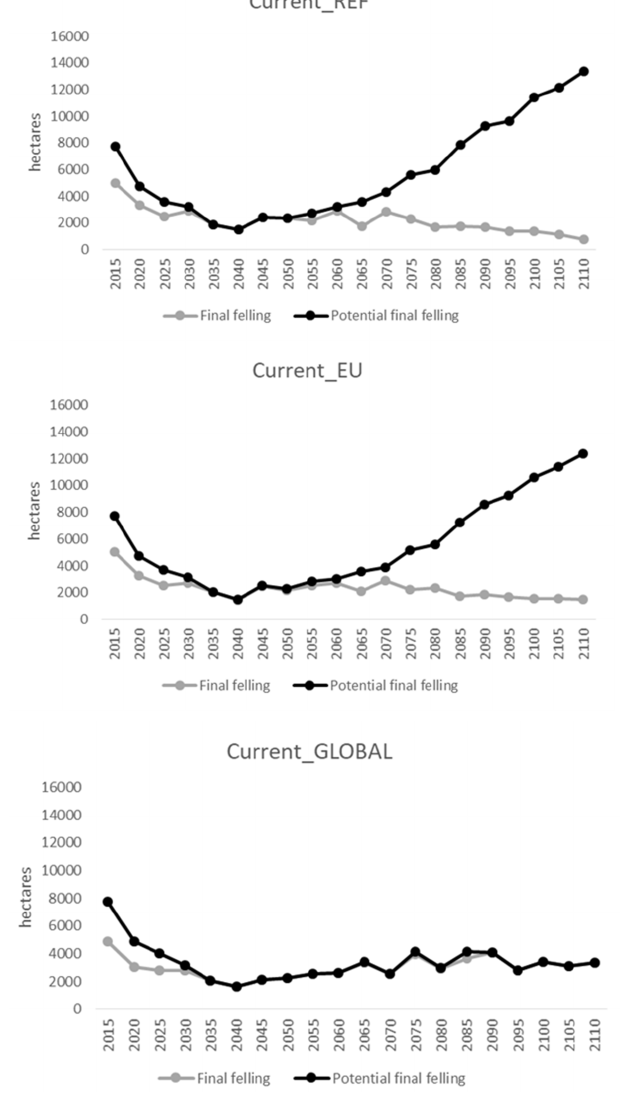
Figure 6. Projected average standing volumes of living trees on productive forestland (> 1 m 3 ha − 1 year − 1 ) with current forest management practices in the three climate change mitigation scenarios.